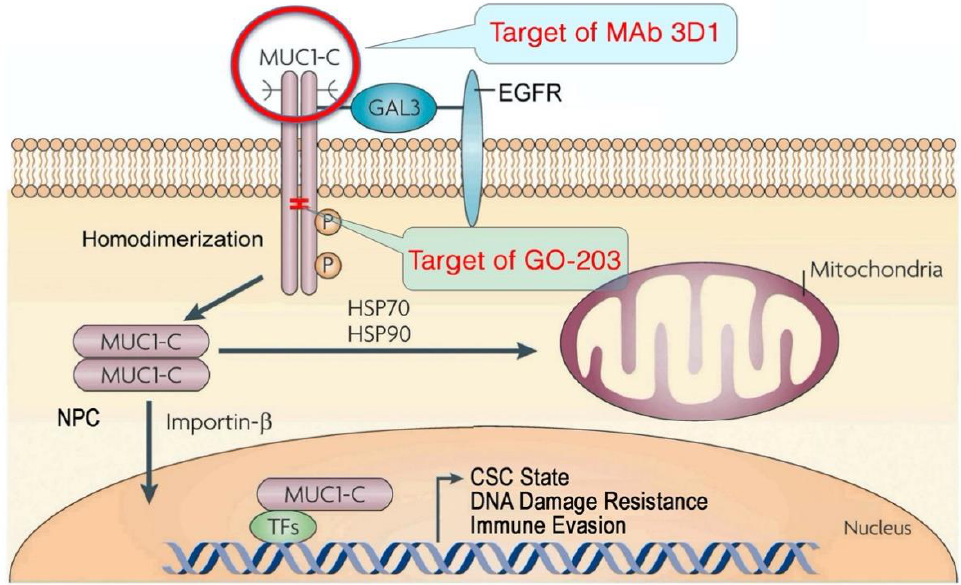
Figure 1. MUC1-C integrates activation of TNBC cell membrane signaling with the induction of EMT, lineage plasticity, DNA damage resistance and immune evasion. Activation of MUC1-C by loss of homeostasis is associated with the formation of homodimers that interact with EGFR and other RTKs at the cell membrane. MUC1-C homodimers are internalized by endocytic trafficking. Intracellular MUC1-C homodimers are transported to the mitochondrial outer membrane, where they block cell death. MUC1-C homodimers are also imported to the nucleus by importin- β and interactions with the nuclear pore complex (NPC). In the nucleus, MUC1-C interacts with TFs, such as WNT/ β -catenin/TCF4, NF- κ B, NOTCH and MYC, to drive EMT, epigenetic reprogramming